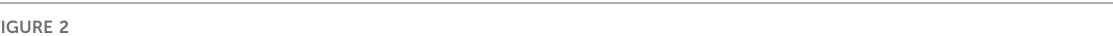
FIGURE 2 (MW n = 8 – 11; SP n = 6 – 7). Median (bold dotted line) and quartiles (light dotted line) are shown and dots represent independent iPSC-beta differentiations or human islet preparations. Symbols represent different cell models (Hel115.6, circles; 1023A, squares, EndoC- β H1, black circles; human islets,triangles).N,numberofindependentexperiments,de fi ned asoneiPSC-betacell differentiation oronehumanislet preparation,shown as individual data points. Mixed-effects analysis followed by Bonferroni correction for multiple comparisons, * p < 0.05, ** p < 0.01, *** p <